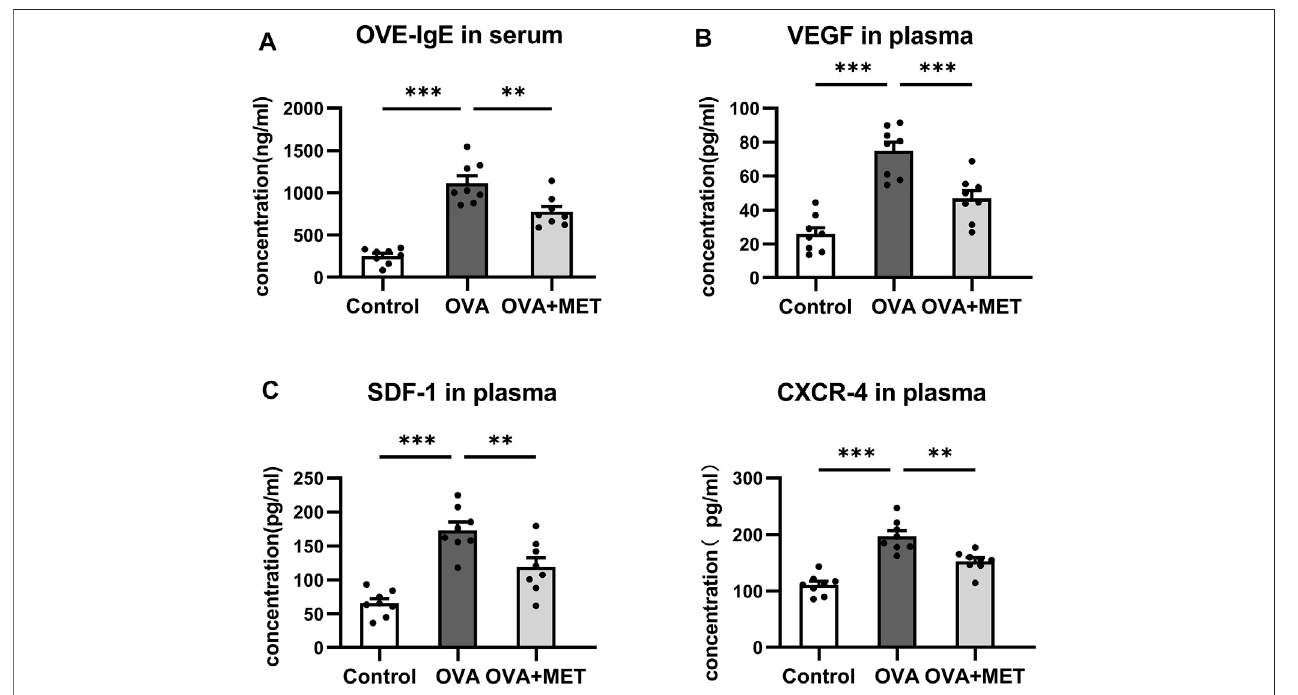
FIGURE5| MetforminreducesthelevelsofOVA-IgEandangiogenesisrelatedcytokinesintheblood. (A) .ComparisonofOVA-IgEconcentrationintheserum. (B) . Comparison of VEGF, CXCR4, and SDF-1 concentrations in the plasma. Data were presented as mean ± SEM. n (cid:1) 8. * p < 0.05, ** p < 0.01, *** p < 0.001.